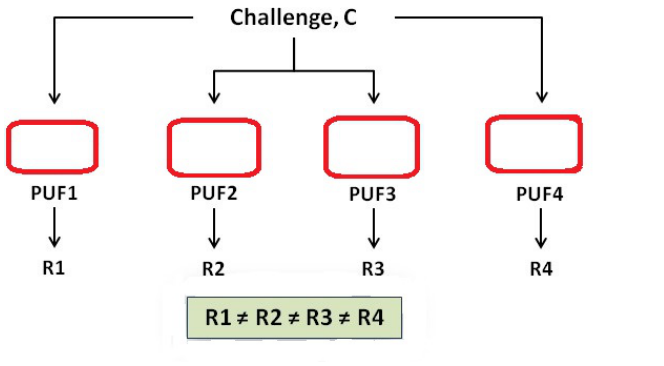
Figure 1. One Challenge with different responses in